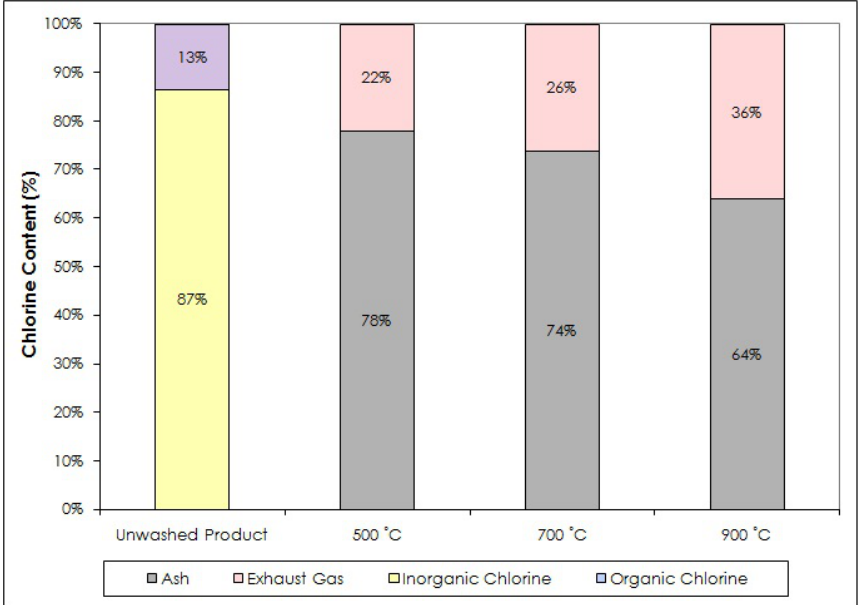
Figure 6. Chlorine contents after combustion of Unwashed Product with different combustion